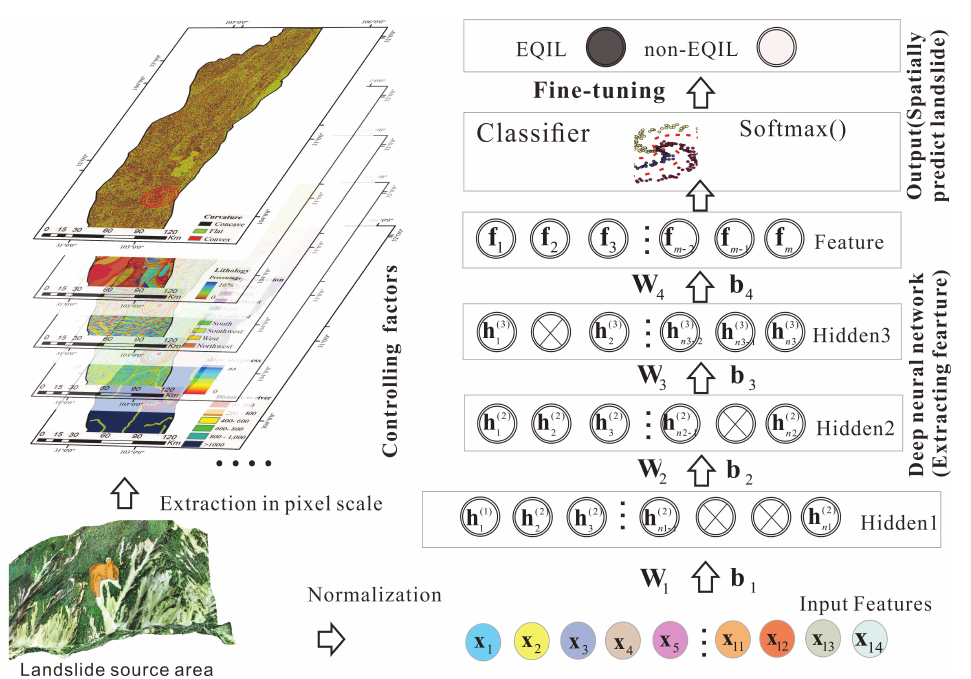
Figure 1. Schematic of the X-TFC framework for solving inverse problems. Figure 2. Spatial prediction frameworks of EQIL. Fourteen kinds of related factors are input to the first layer. Softmax is set as a classifier. We adopt sparse optimization to reduce information